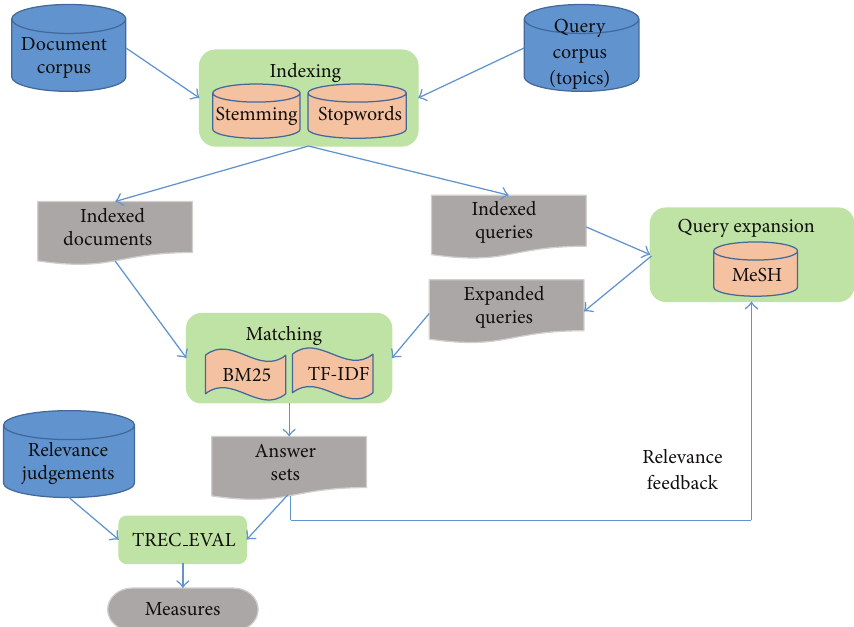
Figure 1: The information retrieval